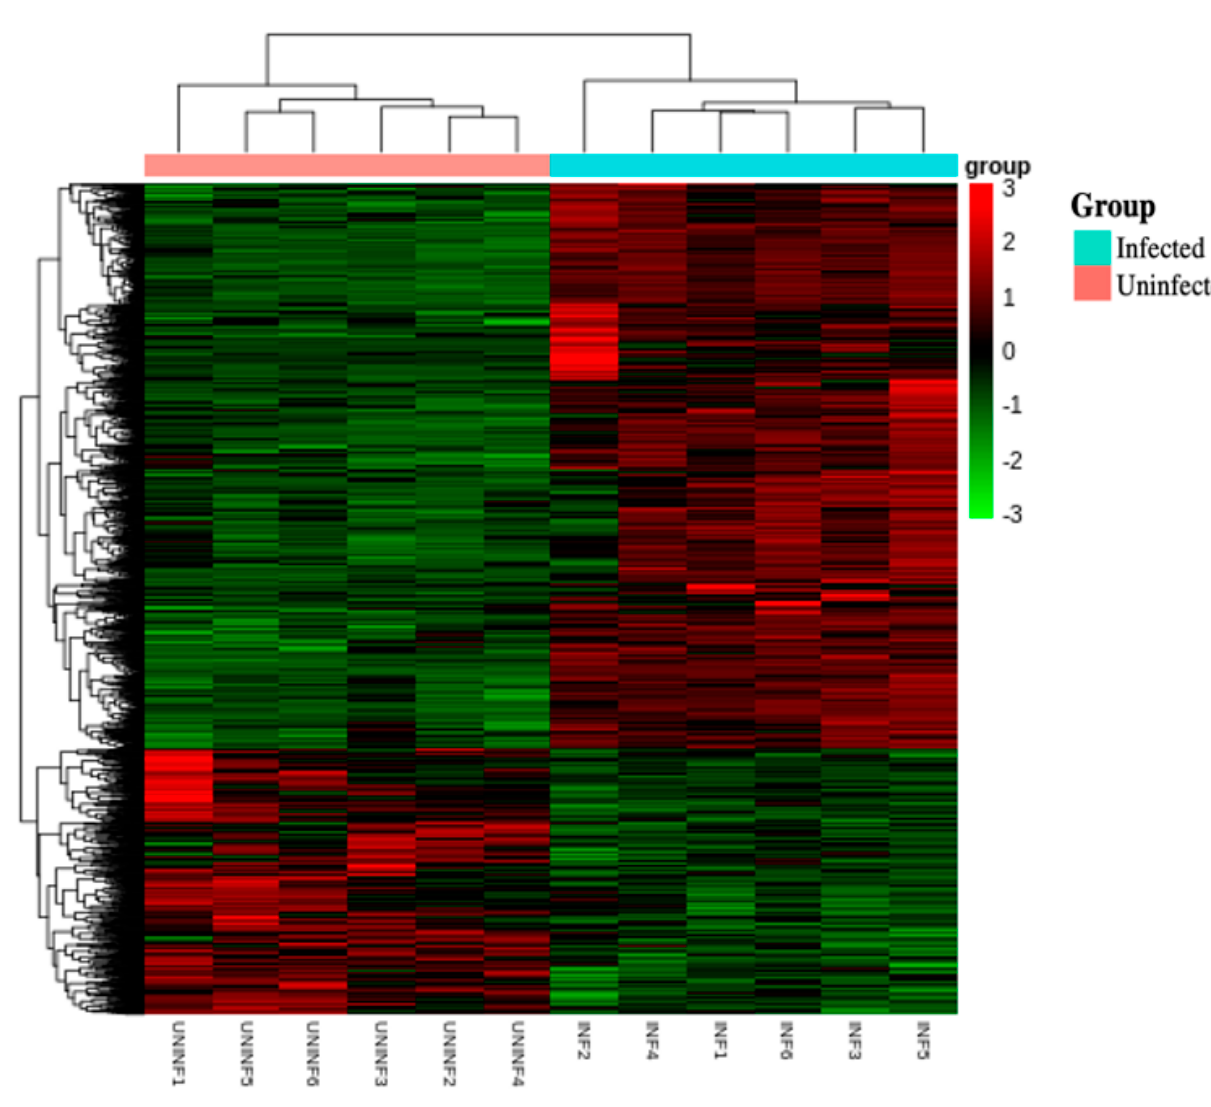
Figure 4. Combined heat map. Here, the red shade represents the more abundant gene expression in the corresponding sample, and green represents the less abundant gene expression.